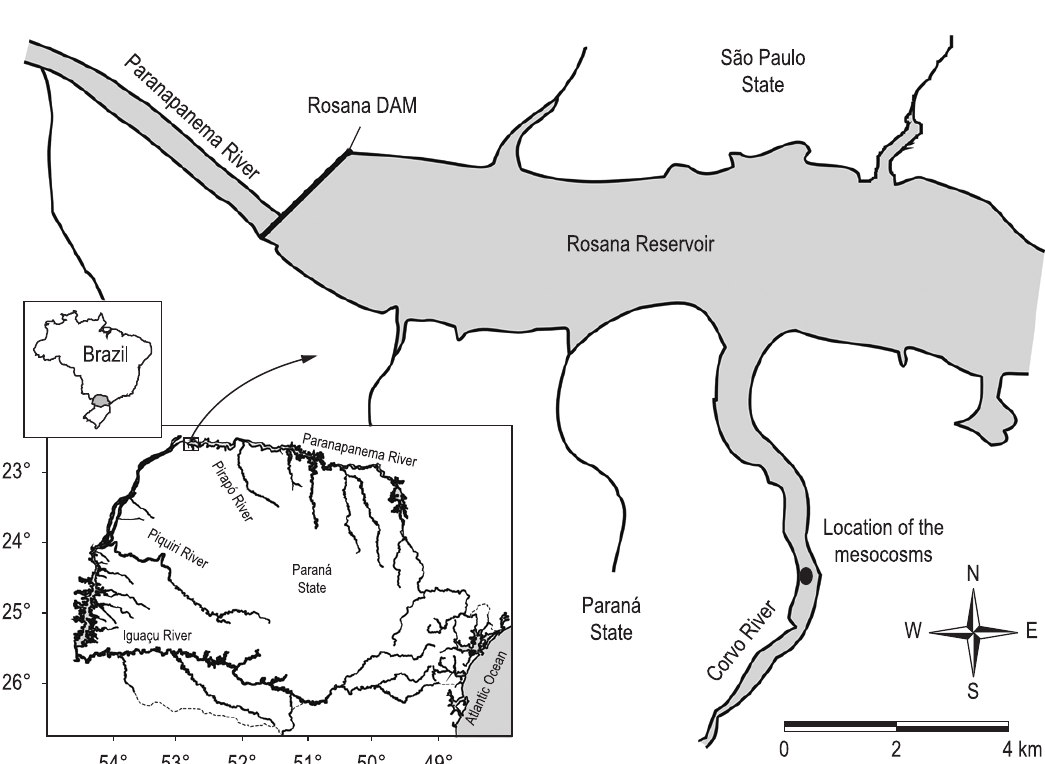
Figure 1. Location of the Corvo river, tributary of the Rosana reservoir (Paranapanema river basin), where were installed the